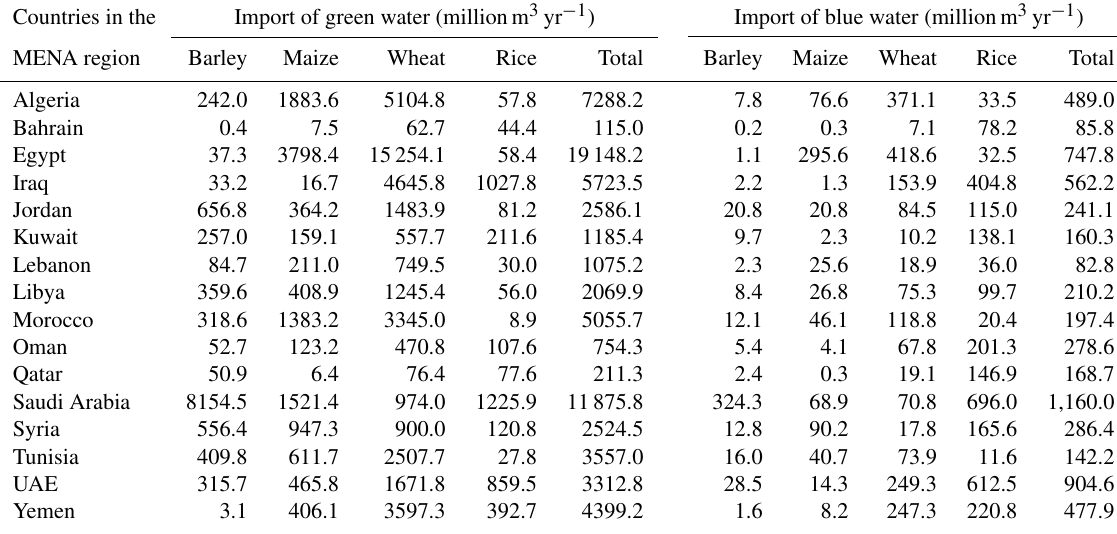
Table 4. The amounts of green and blue water imported in the MENA region from 2000 to 2012. Countries in